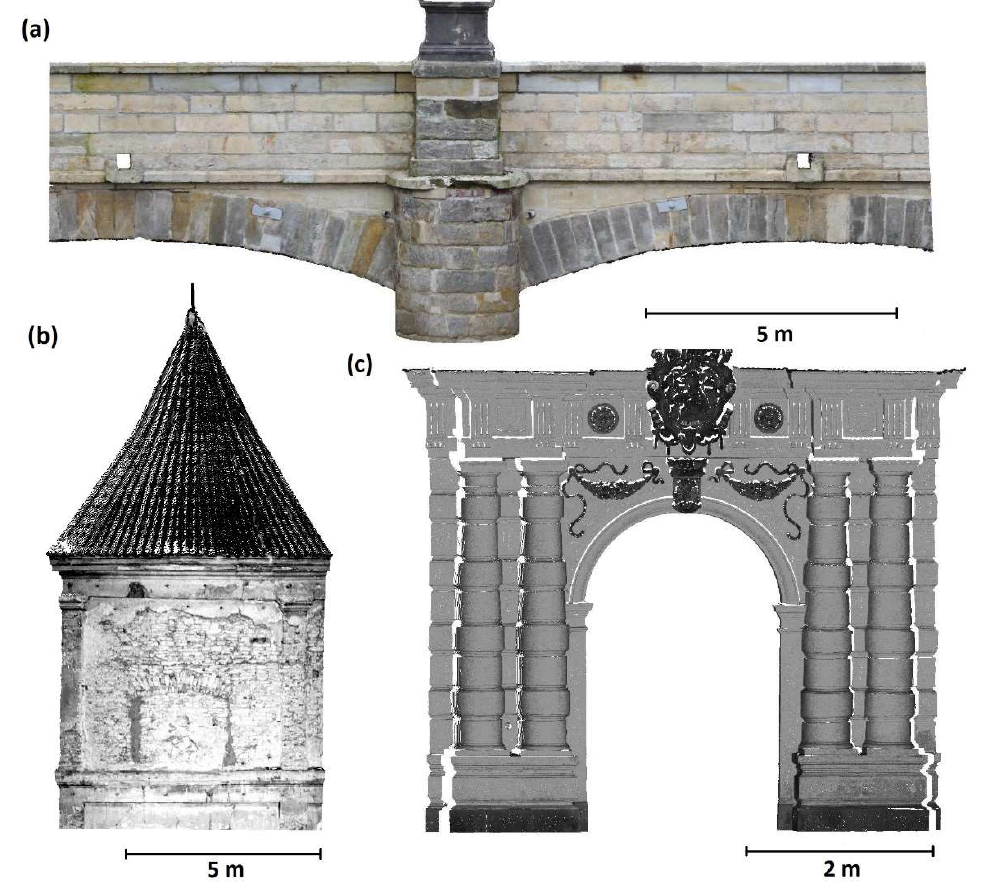
Figure 3. ( a ) Data 1—a part of a historic bridge; ( b ) Data 2—a part of a chapel falling into